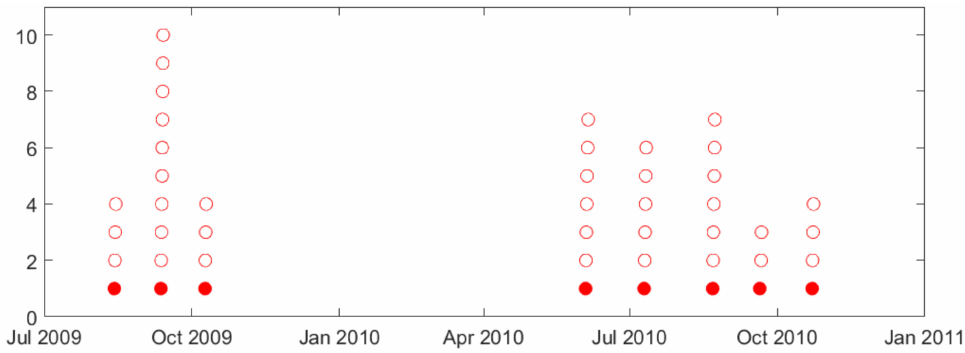
Figure 7. Lead seizures (defined by T = 4 h) for dog L2 during observation period (July 2009– November 2010). Each circle represents an annotated seizure; shaded circles indicate 40 lead seizures (out of 45 total).